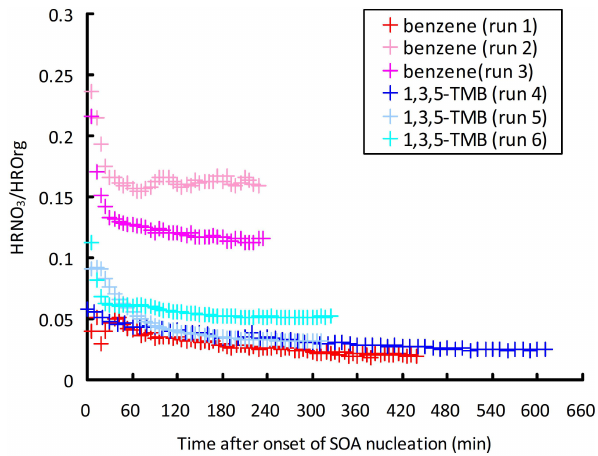
Fig. 5. Time profiles of HRNO 3 /HROrg ratio measured during the photooxidation of benzene and 1,3,5-trimethylbenzene in the pres- ence of NO x . The background of HRNO 3 is very small as shown in Fig. S1a, so the start value of the HRNO 3 /HROrg ratio is not influenced by any background